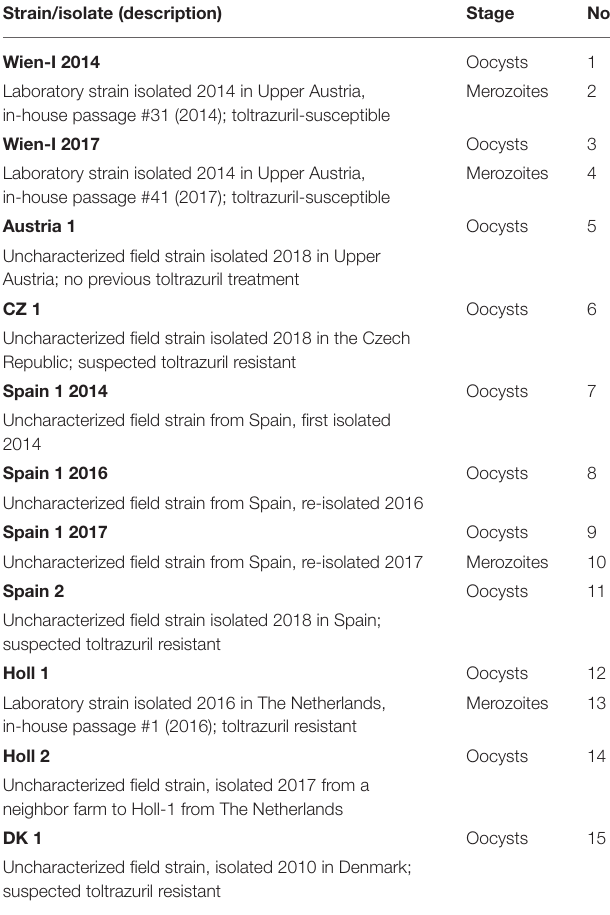
TABLE 1 | Samples investigated in this study. Strain/isolate (description)